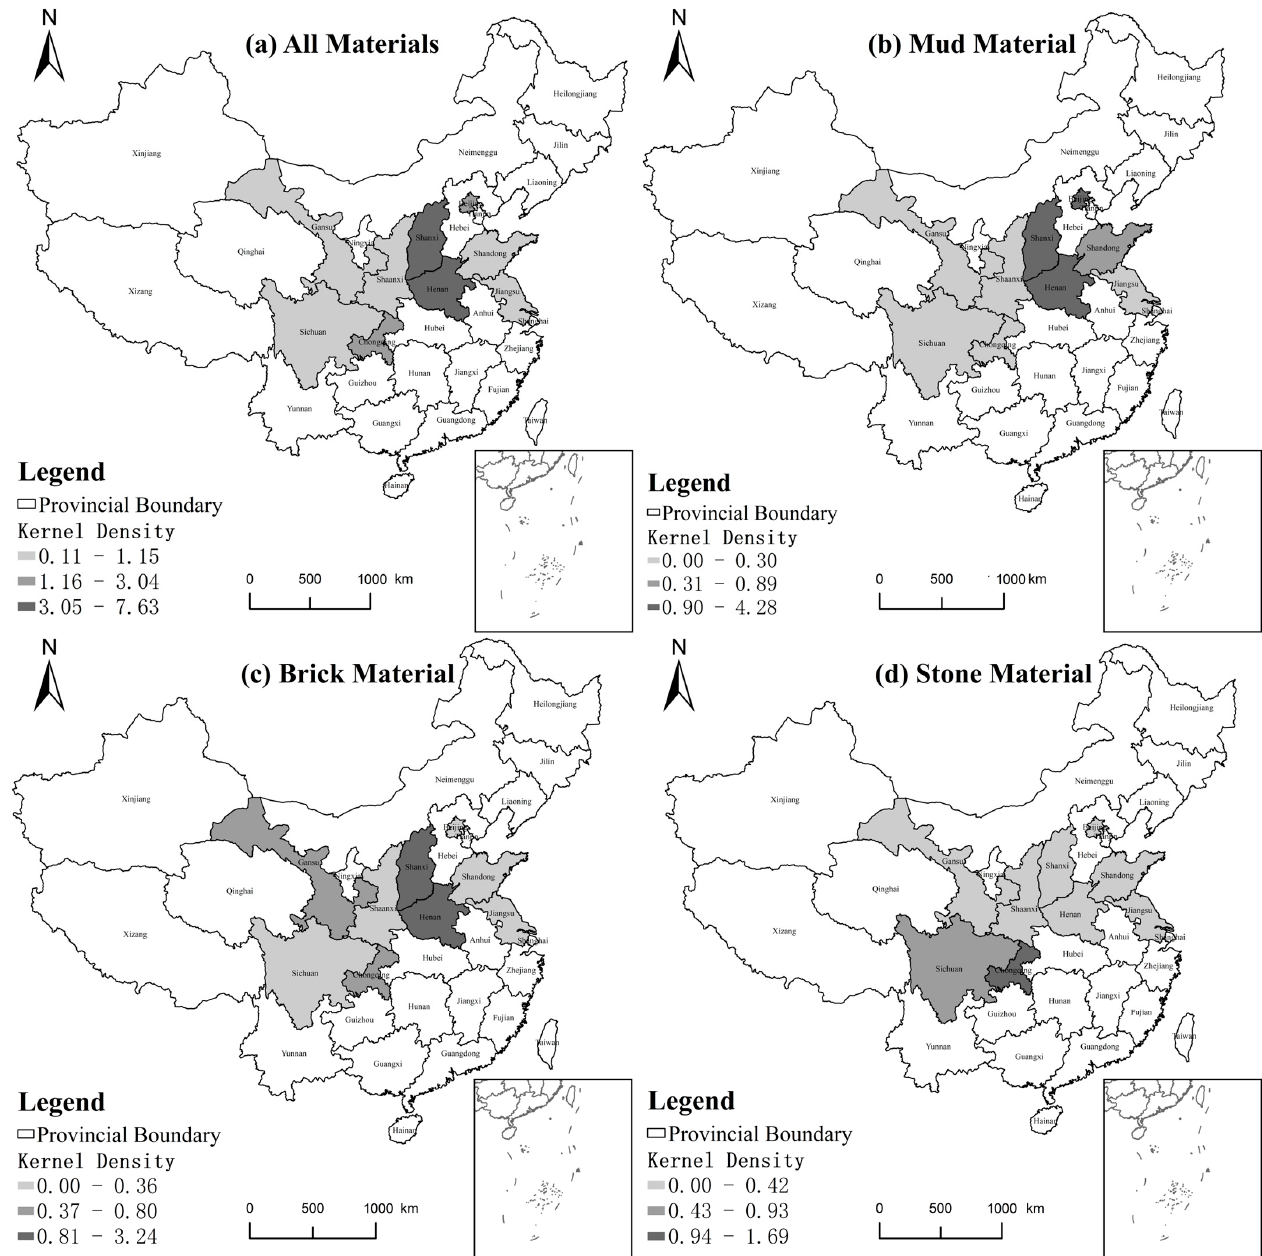
Figure 8. Distribution map of the kernel density of the types of relic sites in the Song, Liao, Jin, and Western Xia Dynasties.